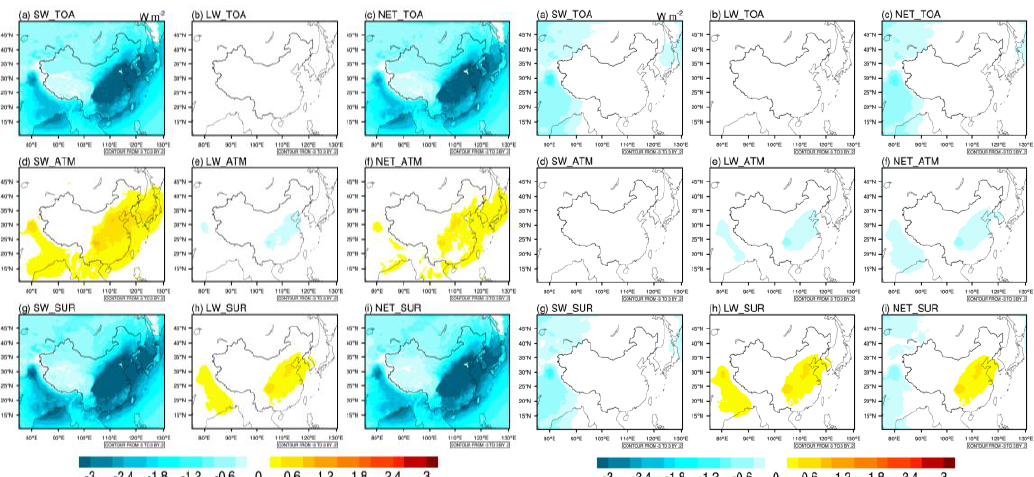
Figure 11. Spatial distributions of the annual average sulfate aerosol direct radiative forcing (W m − 2 ) during the daytime ( left grid) and nighttime ( right grid) in 2010 based on the WRF-Chem model. The direct radiative forcing at the top of the atmosphere (TOA) and the surface are shown at top and bottom of each grid, and that in the atmosphere is shown at middle of each grid. From left to right: shortwave, longwave and net radiation.